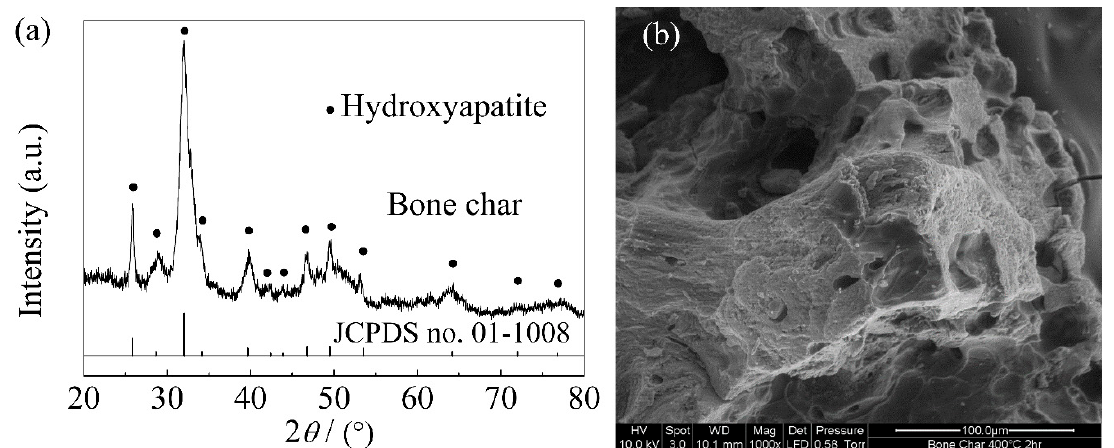
Figure 1. ( a ) XRD pattern of bone char and ( b ) SEM image [15] of bone char.